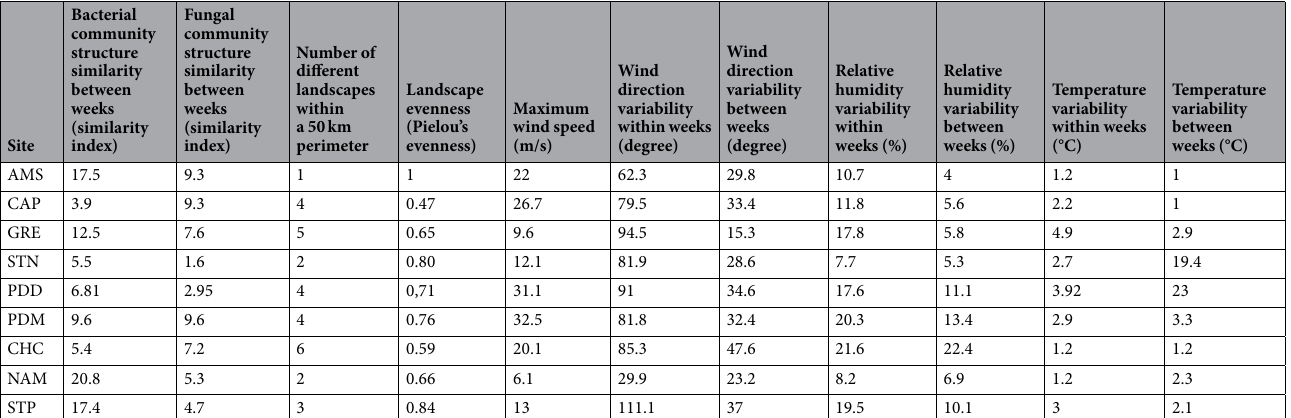
Table 2. Temporal variability of the microbial community structure and meteorological conditions at each site. The similarity index was calculated as following: (1 – Bray-Curtis dissimilarity value averaged per site)/standard deviation. The maximum wind speed (m/s) per site, the variability of the wind direction (degree), relative humidity (%) and temperature (°C) within a week and between the weeks, the number of different landscapes within a perimeter of 50 km and the landscape evenness are